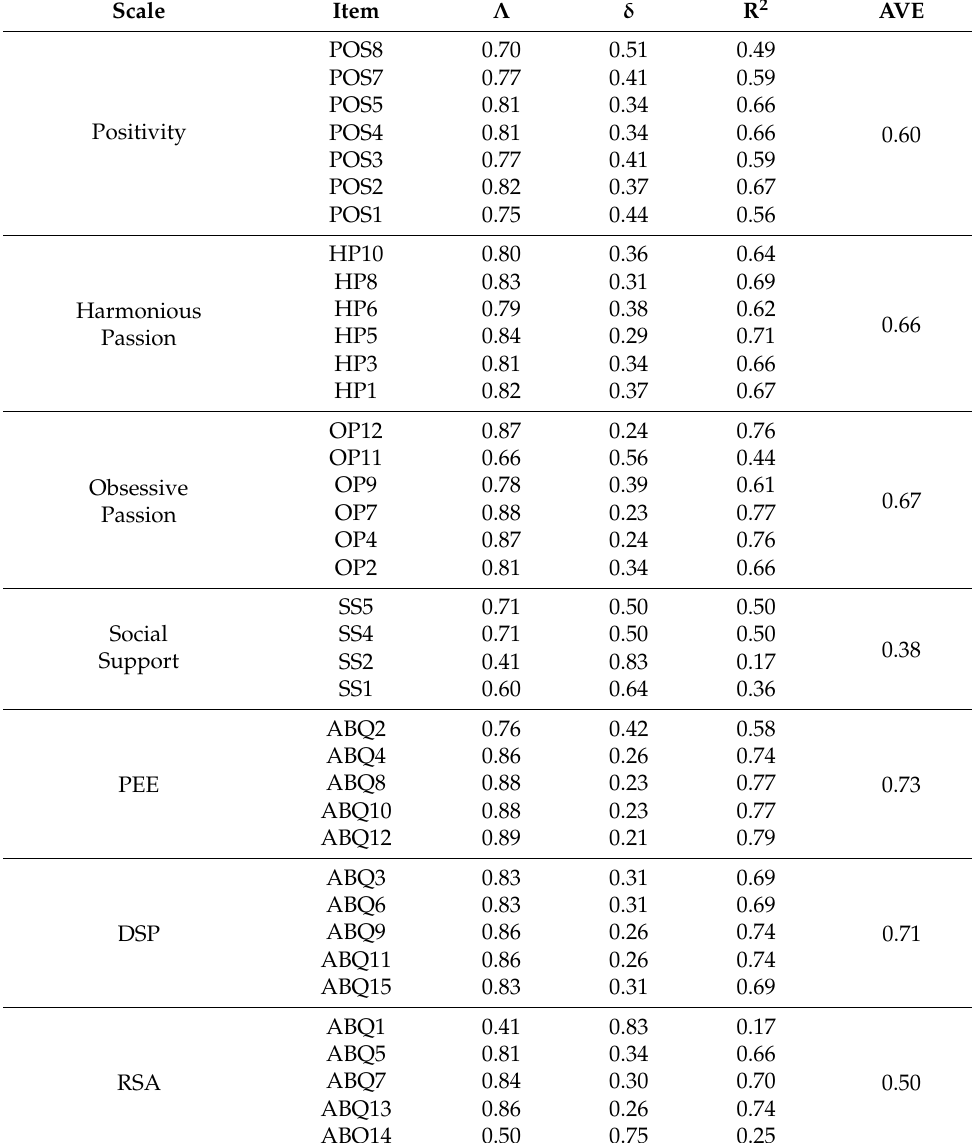
Table 2. Estimates for all items of the model and AVE.